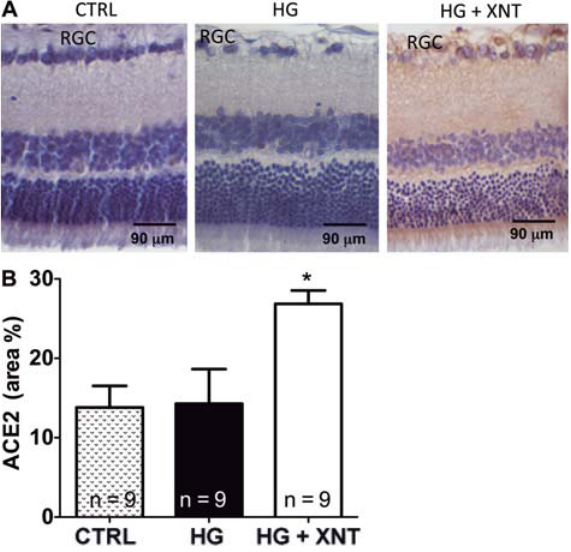
Figure 1. Administration of 1-[[2-(dimethylamino) ethyl] amino]- 4-(hydroxymethyl)-7-[[(4-methylphenyl) sulfonyl] oxy]-9H-xanthone 9 (XNT) increased angiotensin converting enzyme 2 (ACE2) expression in retinas of hyperglycemic rats. A , Representative photomicrographs of retinas of control rats (CTRL), hyperglycemic untreated rats (HG), and hyperglycemic treated rats (HG + XNT). RGC: retinal ganglion cells. B , Quanti fi cation of ACE2 expression in retinas of rats. *P o 0.05 compared to CTRL and HG groups (one-way ANOVA followed by the Newman-Keuls test).